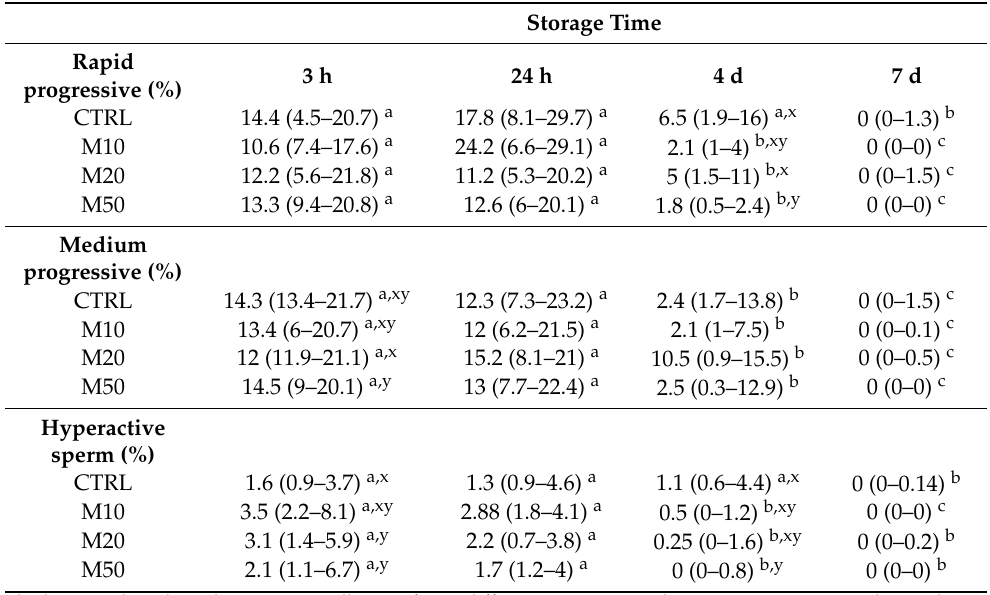
Table 2. Sperm subpopulations (% of rapid, medium and hyperactivated spermatozoa) of canine ( n = 9) semen of control (CTRL) and semen extender Maca treatment groups (M10, M20 and M50) during storage at 4 ◦ C for 7 days. All values are expressed as median and interquartile range (IQR).